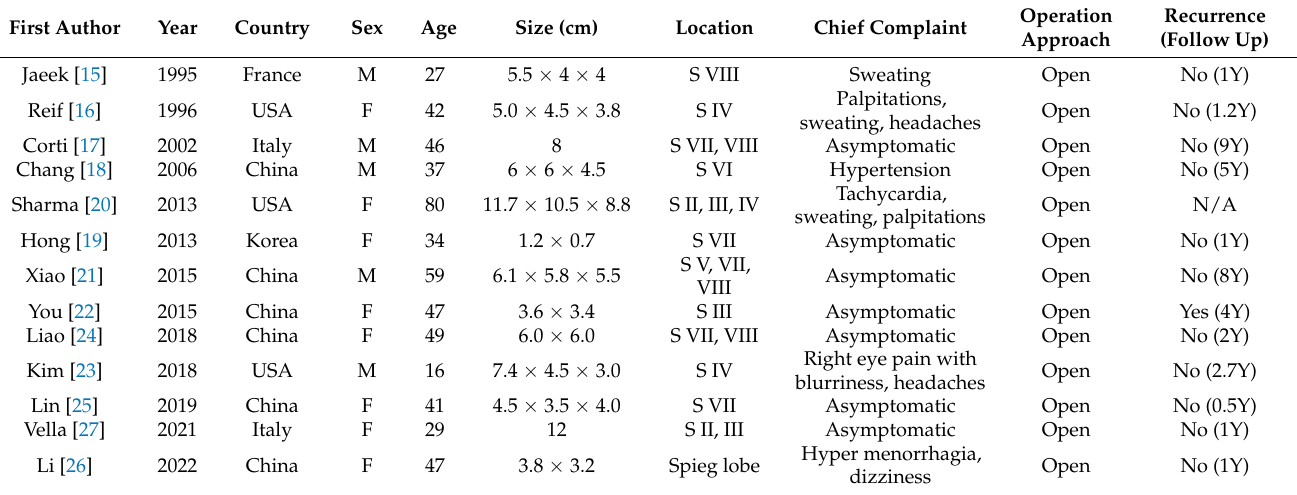
Table 2. Literature review of hepatic paragangliomas undergoing surgical